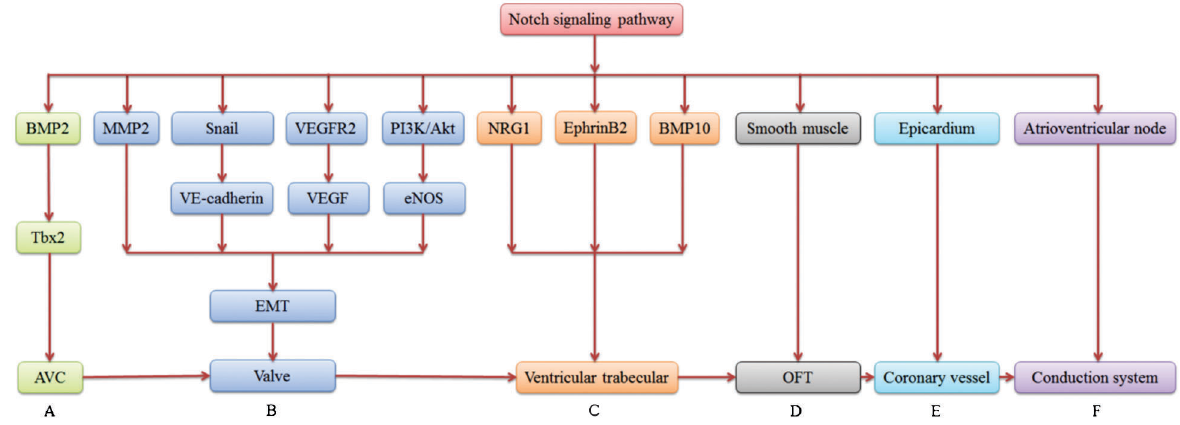
Figure 2. Summary of cardiac developmental aspects of Notch signaling. A , Notch signaling affects AVC development via BMP 2/Tbx 2 pathway. B , Notch signaling initiates EMT via MMP-2, snail/VE-cadherin, VEGFR2/VEGF, and PI3K/Akt/eNOS pathways. EMT is a required step for valve development. C , Notch signaling promotes ventricular trabecular formation dependent on NRG1-ErbB2/4, Ephrin B2/Eph B4, and BMP-10 signaling pathways. D , Notch signaling stimulates smooth muscle differentiation during OFT development. E , Notch signaling modulates coronary vessel morphogenesis in which the embryonic epicardium actively participates. F , Notch signaling regulates cardiac conduction system function via effects on the atrioventricular node. AVC: atrioventricular canal; BMP- 2: bone morphogenetic protein-2; Tbx2: T-box 2; EMT: epithelial-to-mesenchymal transition; MMP-2: matrix metalloproteinase-2; VEGFR 2: vascular endothelial growth factor receptor 2; VEGF: vascular endothelial growth factor; BMP-10: bone morphogenetic protein-10; OFT: outflow